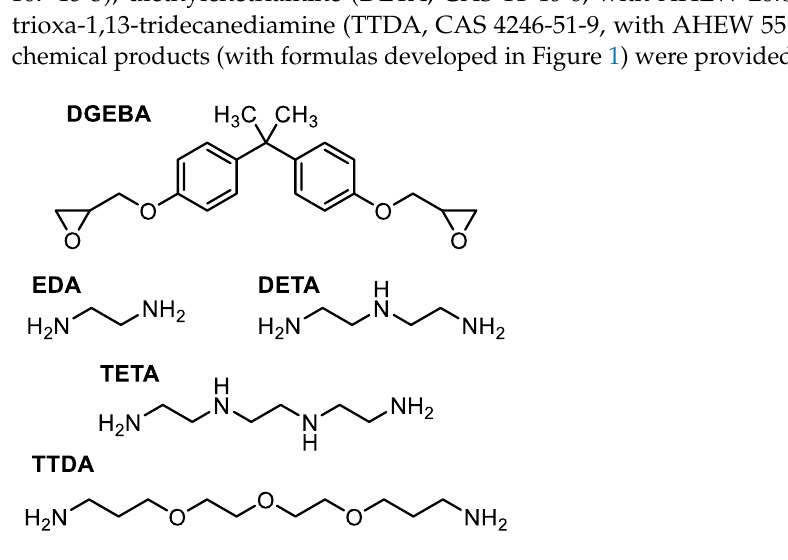
Figure 1. Chemical formulas of epoxide prepolymer and hardeners used to synthesize the networks under investigation.